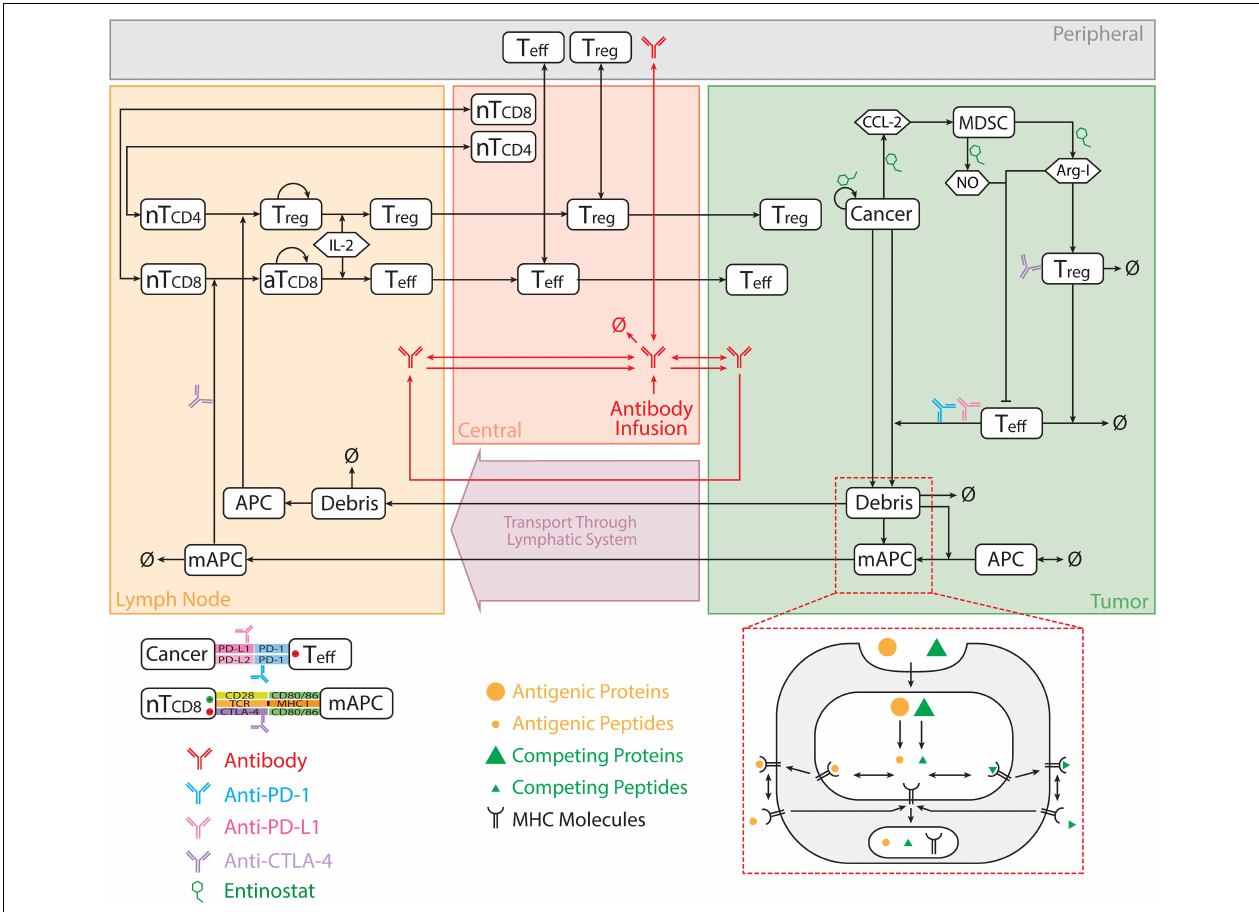
FIGURE 1 | Model diagram. The model is comprised of four compartments: central, peripheral, tumor, and tumor-draining lymph node, which describe cycles of immune activation in lymph nodes, T cell trafficking to the tumor, killing of cancer cells, immune evasion, and antigen release and lymphatic transport. Anti-CTLA-4 antibody blocks interaction between CD80/86 and CTLA-4 on mAPC and naïve T cell, respectively, in lymph nodes, and induces ADCC-mediated Treg depletion in the tumor. Anti-PD-1 antibody blocks interaction between PD-1 and PD-L1/2 on Teff and cancer cell, respectively, in the tumor. nT, naïve T cell; aT, activated T cell; NO, nitric oxide; Arg-I, arginase I; Treg, regulatory T cell; Teff, effector T cell; mAPC, mature antigen presenting cell. The figure is adapted from Jafarnejad et al.